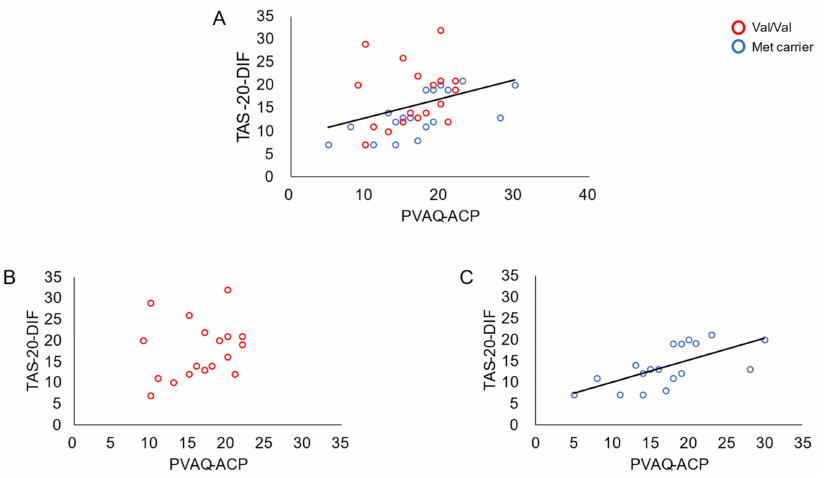
Figure 1. Correlation between the scores of the 20-item Toronto Alexithymia Scale—an index of difficulty identifying feelings—and the pain vigilance and awareness questionnaire—an index of attention to changes in pain. ( A ) Correlation in all participants. ( B ) Correlation in the Val/Val group. ( C ) Correlation in the Met-carrier group. Red and blue circles indicate the data of Val/Val participants and Met carriers,